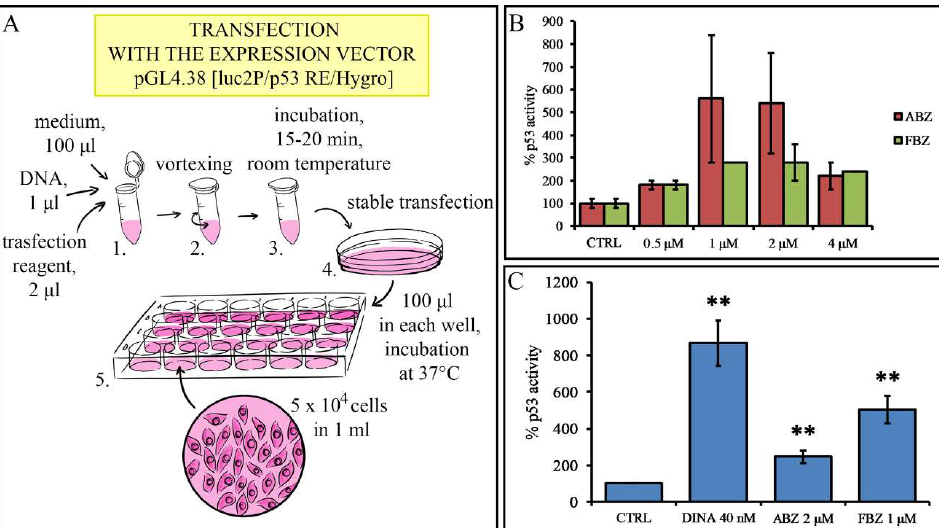
Figure 2. Luciferase assay of A375 melanoma cell line carrying a p53 activity luciferase reporter construct. ( A ) Scheme of HTS screening of 2448 compounds. ( B ) HTS revealed albendazole (ABZ)